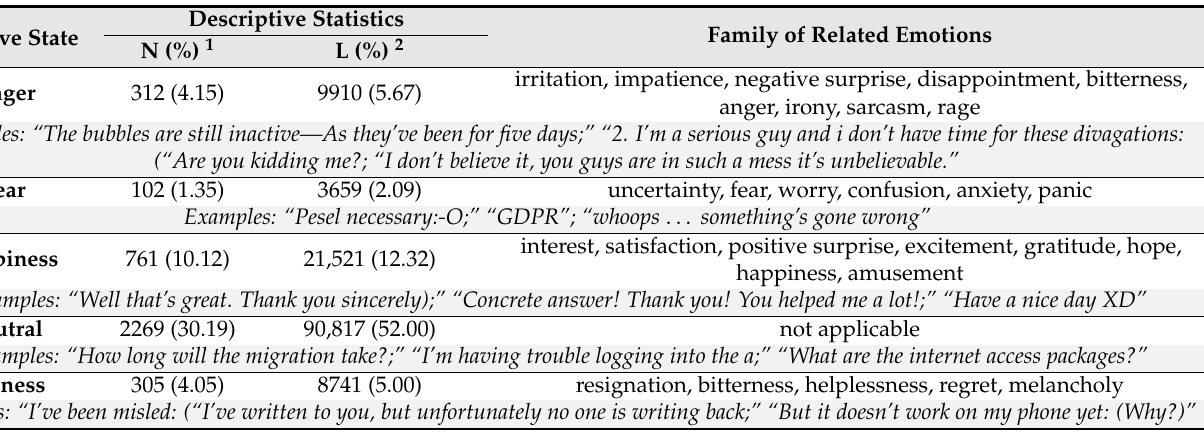
Table 3. Frequency analysis of the emotional coloring of utterance fragments in Sample 1 (text